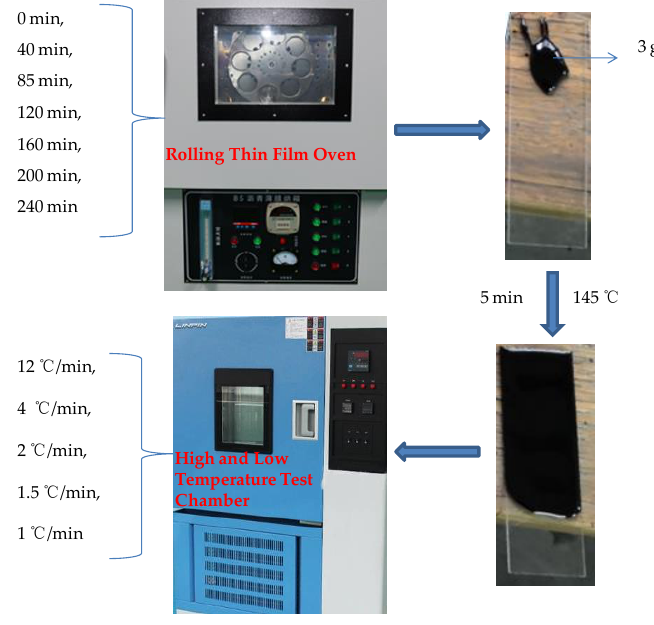
Figure 1. The preparation process of the atomic force microscopy (AFM) sample.